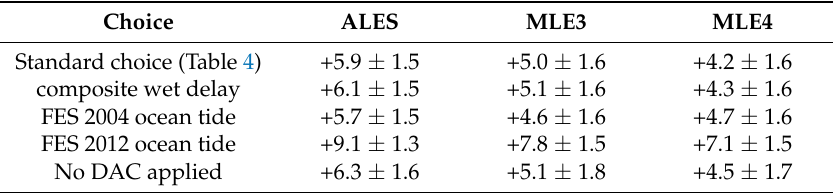
Table 8. Residual SLA, standard deviation w.r.t. tide gauge-based sea level (cm), for case 1, after 3-month smoothing, with different geophysical corrections choices.